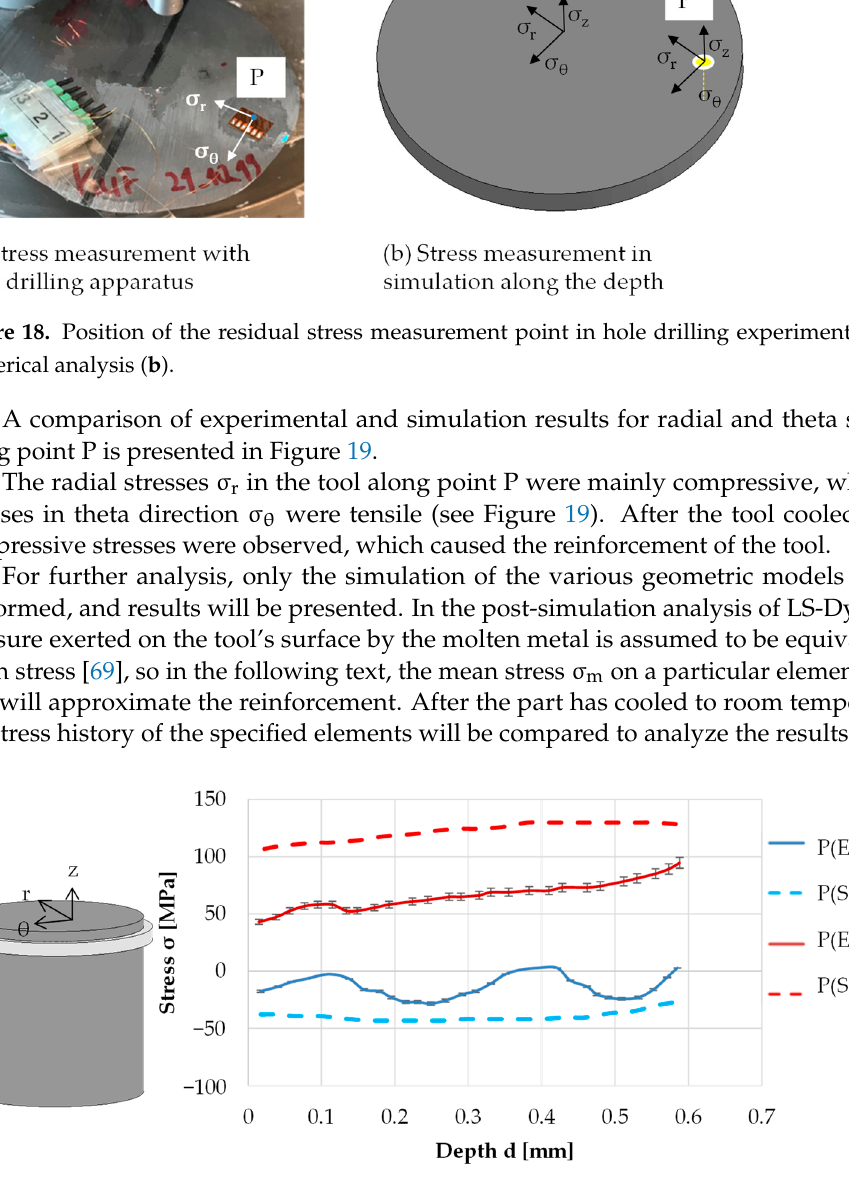
Figure 19. Residual stress history along the hole-depth at point P in the experiment and